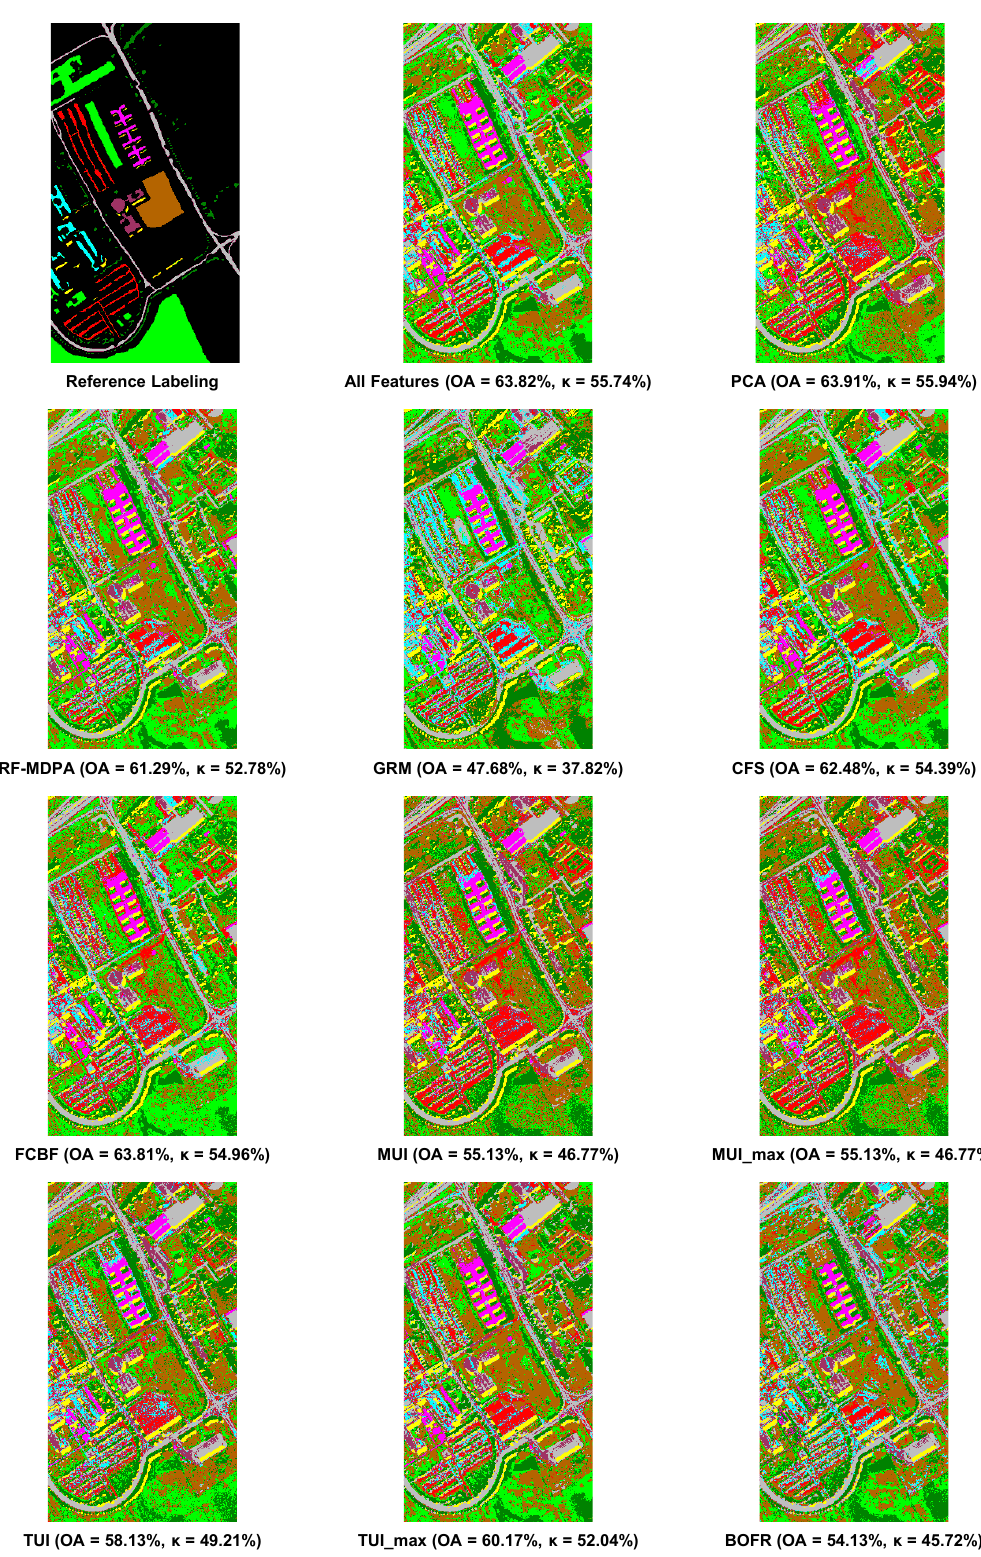
Figure 11. Classified scene for the Pavia University dataset when using the RF classifier and different feature sets. The values in brackets refer to the evaluation on the test